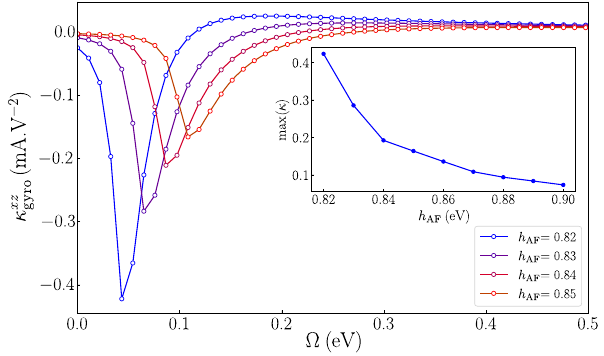
FIG. 7. Frequency dependence of the gyration current coef- ficient when changing the molecular field h parameters are the same as Eq. (151). The inset plots the maximum magnitude of κ xz